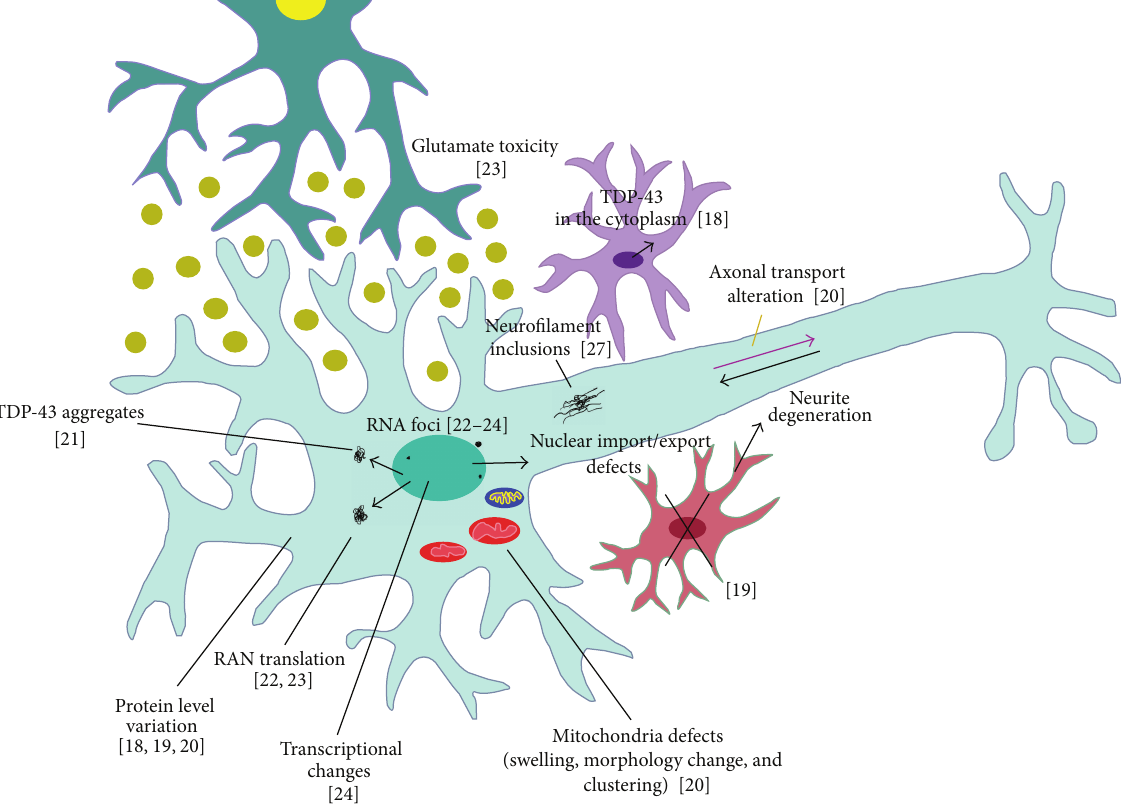
Figure 1: Overview representation of disease pathogenesis of ALS and FTD in cells derived from patient somatic lines. Neurons/motor neurons were differentiated from human induced pluripotent stem cells and varied phenotypes were observed: mutant protein may be mislocalized into a different cellular compartment (TDP-43 [17, 18]); overexpression and downregulation of mutant proteins were observed [18–20]; formation of cellular aggregates [21]; formation of repeat-associated non-ATG (RAN) peptides [22, 23]; formation of RNA foci [22– 24];glutamatetoxicity[23];mitochondriadefects[20];nuclearimport/exportimpairment[25,26];formationofneurofilamentinclusions[27] and axonal transport defects [20]. In the absence of glia, SOD1 models formed neurofilament inclusions which lead to neurite degeneration in motor neurons